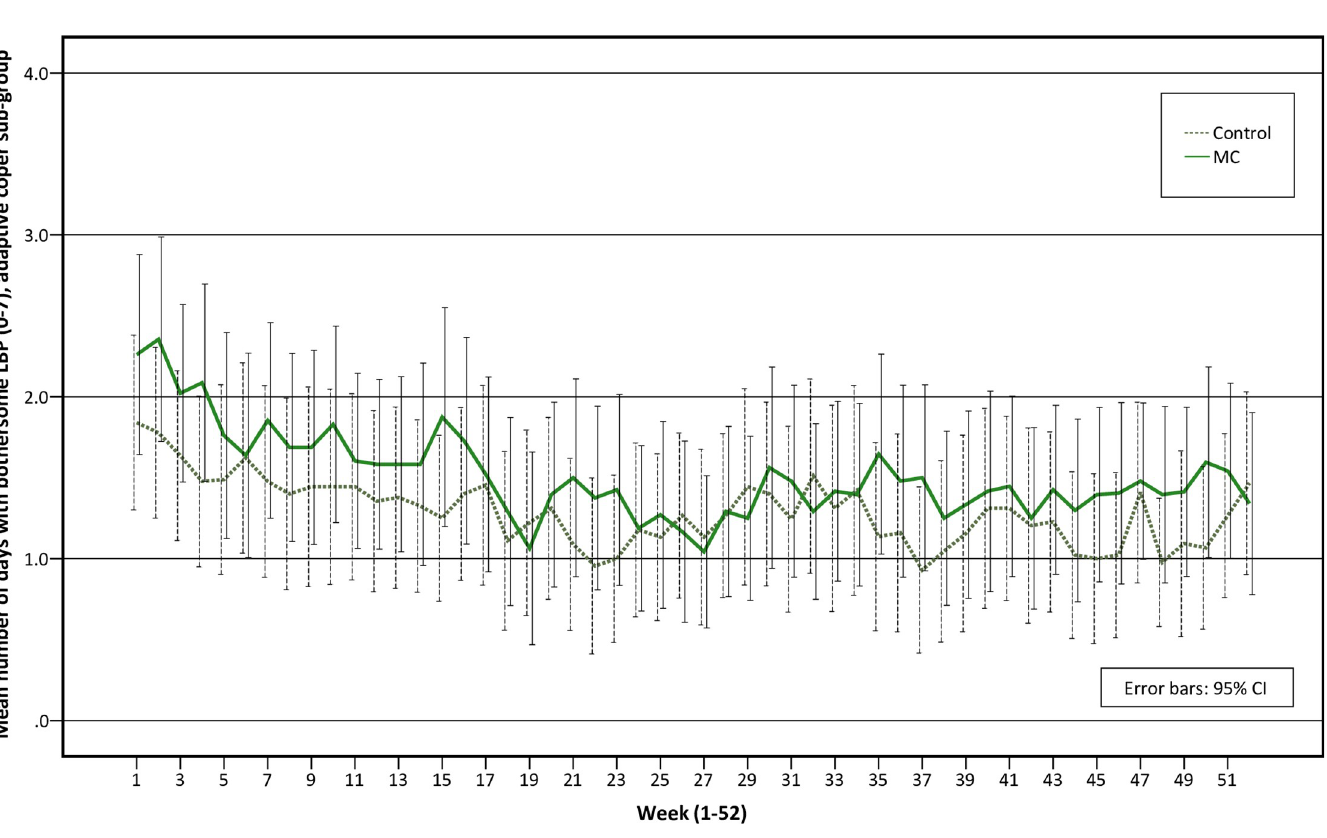
Fig 3. Pain trajectories for treatment groups in the adaptive coper sub-group.